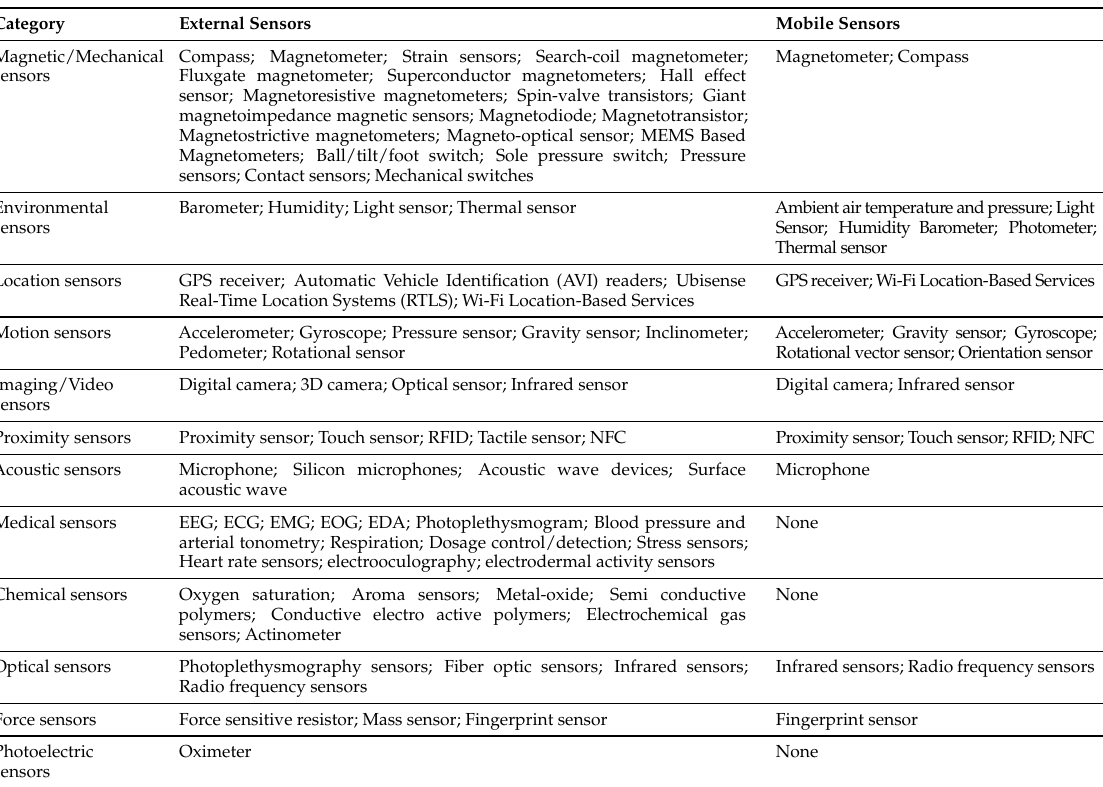
Table 1. Sensors classified by